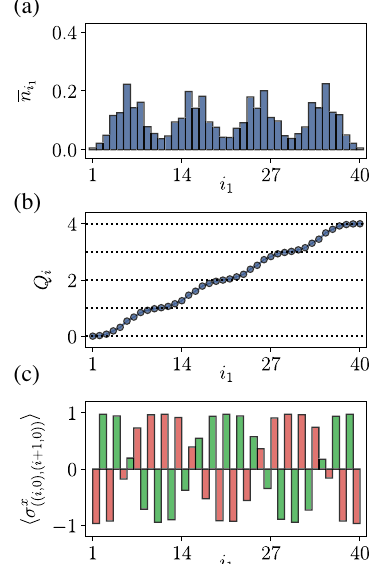
FIG. 9. Finite doping and soliton-induced deconfinement. (a) Real-space fermionic occupation for a ladder of length N s ¼ 40 filled with N ¼ 44 particles for Δ ¼ 4 t , h ¼ 0 . 2 t , and J ¼ 0 , where the formation of a periodic crystalline structure can be appreciated. (b) Integrated charge Q along the ladder, showing i that each peak of excess charge with respect to half-filling contains a fermionic number of one. (c) Corresponding electric- field configuration h σ x in the lower leg of the ladder; ( ð i; 0 Þ ; ð i þ 1 ; 0 Þ ) i odd links are red, and even ones are green. Topological solitons between the two degenerate electric-field configurations appear, and the peaks of excess charge are located at the position of the defects.